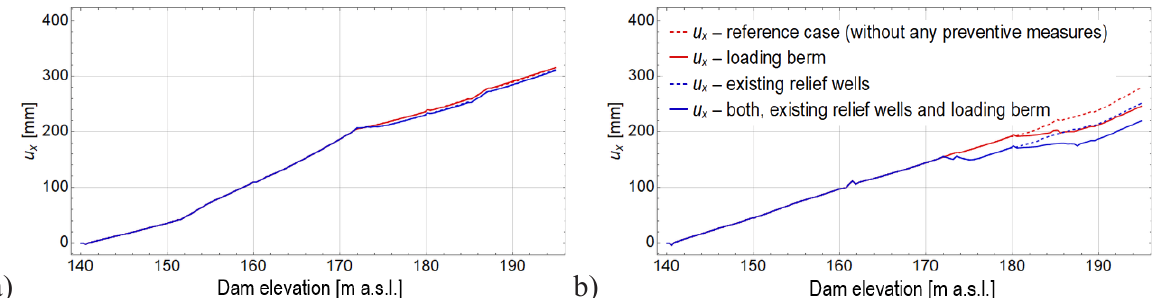
Fig. 9. Horizontal displacement ( u x [mm]) as a function of dam elevation: a ) cross- section VIIIN and b ) cross- section VaN.